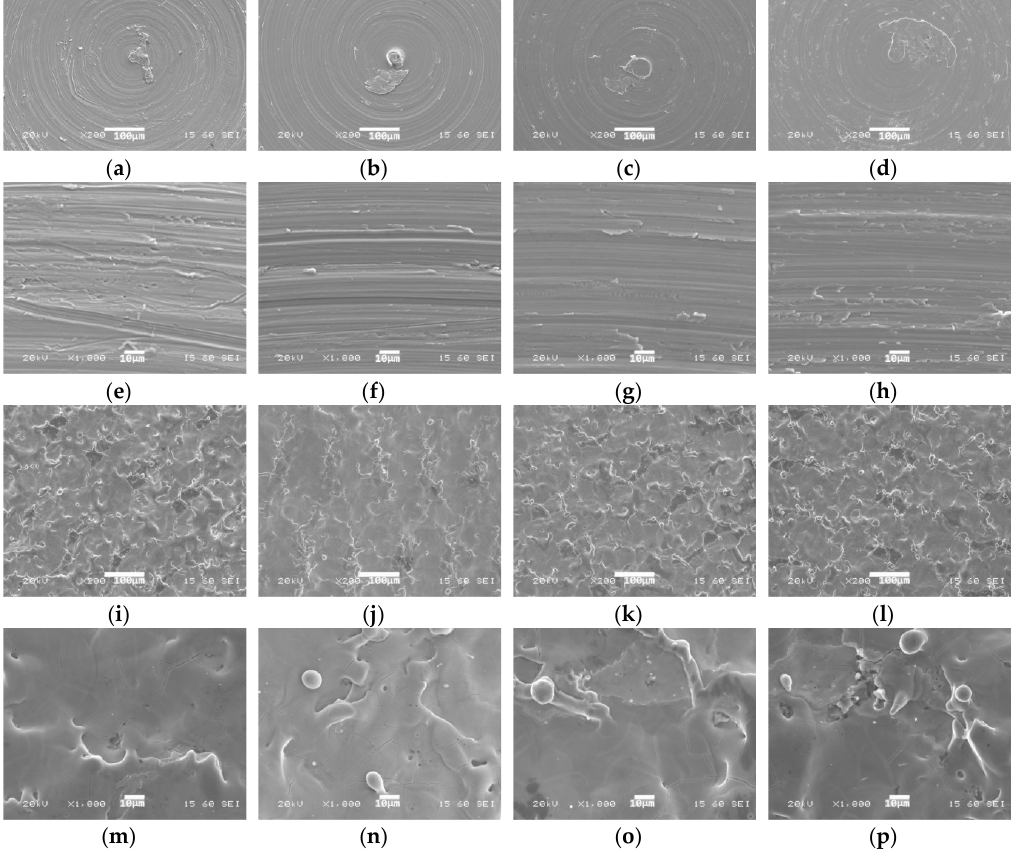
Figure 2. Scanning electron micrographs of the surfaces of samples: ( a , e ) cpTi2 and ( i , m ) cpTi2L; ( b , f ) nTi2 and ( j , n ) nTi2L; ( c , g ) cpTi4 and ( k , o ) cpTi4L; ( d , h ) nTi4 and ( l , p ) nTi4L. Magnification: 200× ( a – d , i – l ) and 1000× ( e – h , m – p ).